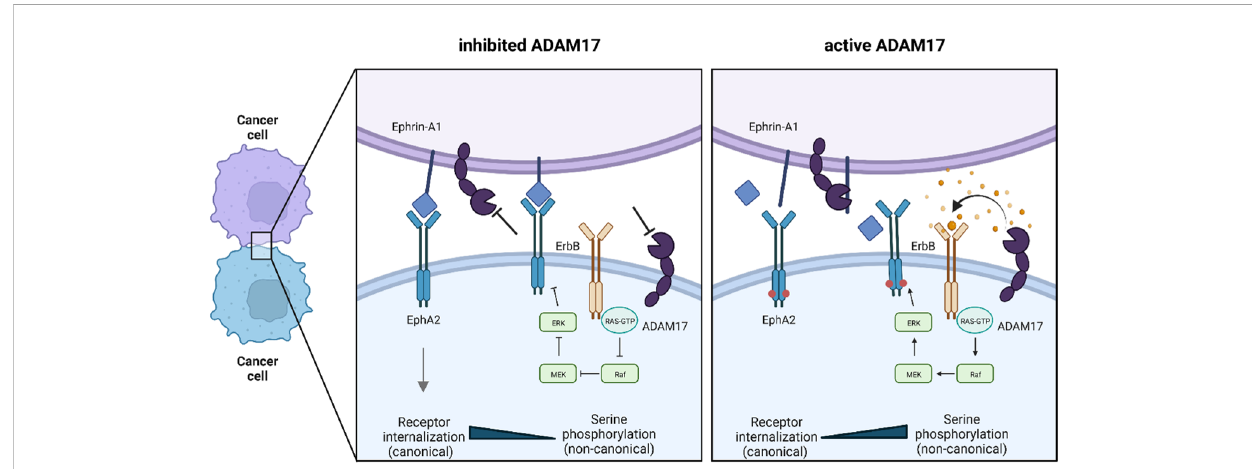
FIGURE 6 Graphical abstract: The dual role of ADAM17 on EphA2 signaling. Based on our data, ADAM17 in fl uences EphA2 signaling by two mechanisms: 1) Release of growth factors that act on EphA2 pS897 via the MAPK pathway and thereby activate the non-canonical pathway. 2) Cleavage of GPI- anchored ephrin-A1 to prevent receptor internalization and thereby blocking the canonical signaling pathway. In red: EphA2 S897